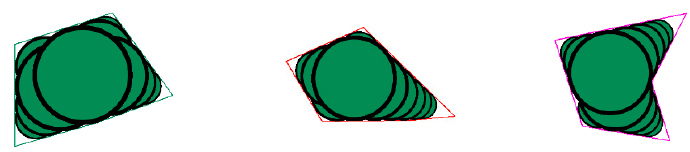
Figure 4. The resulting particle mode.